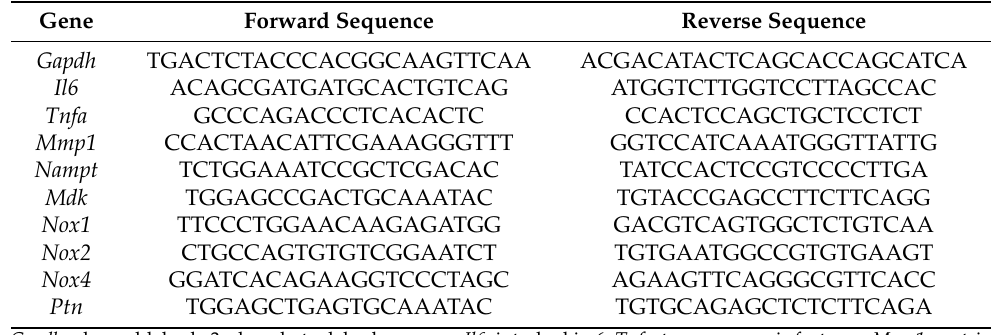
Table 1. Primers’